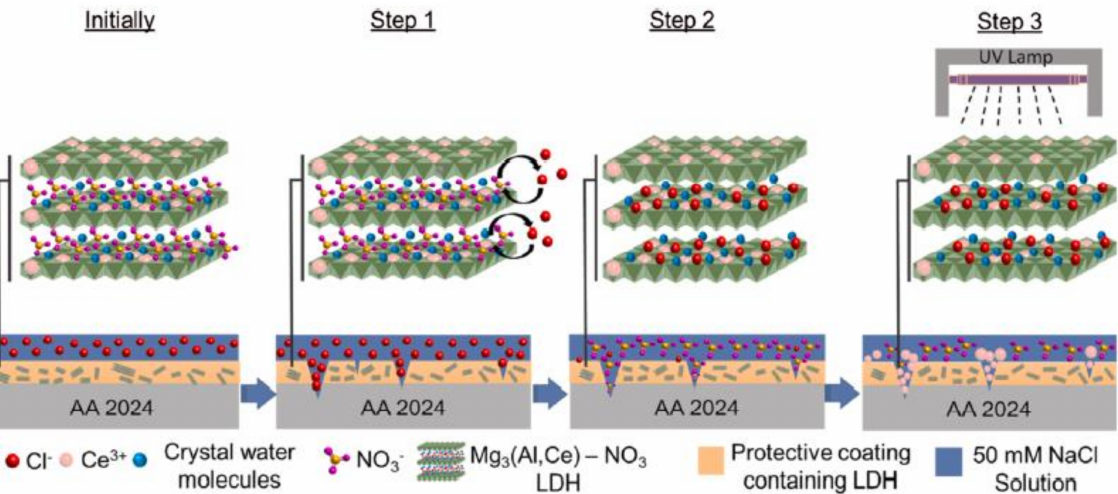
Figure 16. Schematic presentation of LDH structure. Reprinted with permission from Ref. [70]. Copyright 2022,